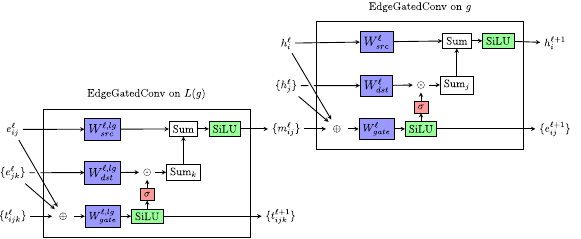
Fig. 2 Schematic of the ALIGNN layer structure. The ALIGNN layer fi rst performs edge-gated graph convolution on the line graph to update pair and triplet features. The newly updated pair features are propagated to the edges of the direct graph and further updated with the atom features in a second edge-gated graph convolution applied to the direct